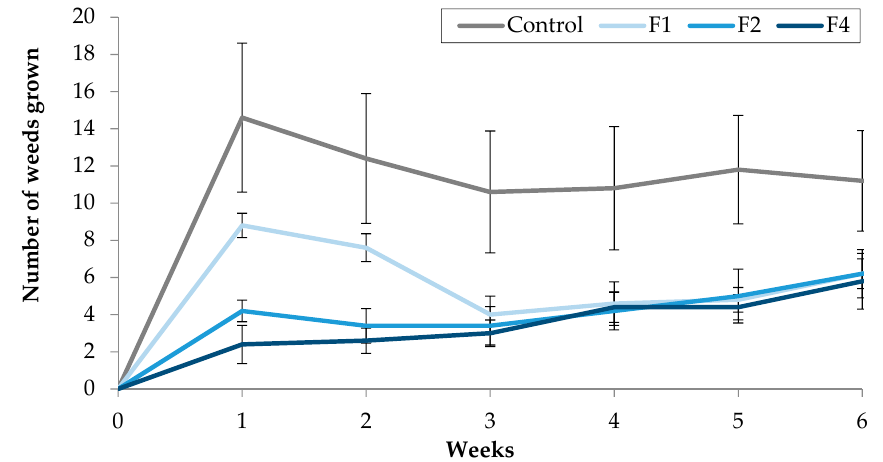
Figure 7. E ff ect of TC3, supplied with water, using Fitoil as emulsifier, on the number of weeds grown in treated pots.